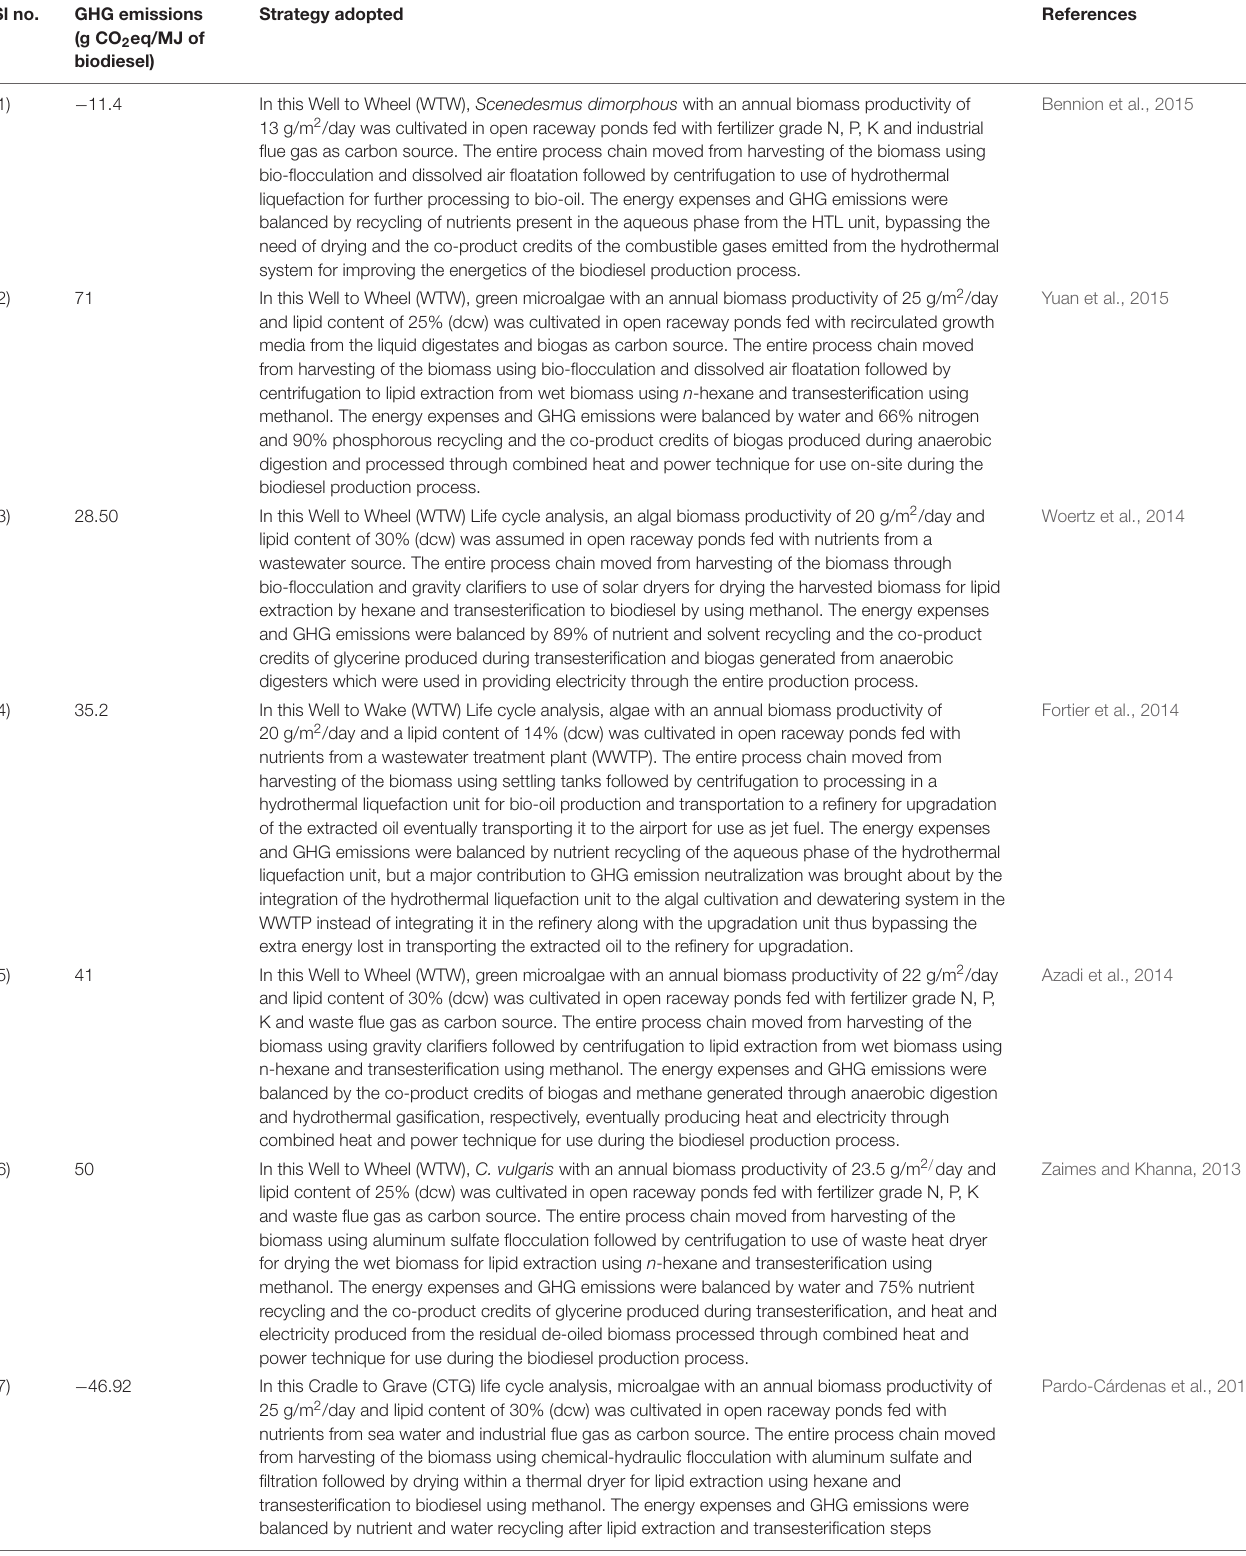
TABLE 4 | GHG emissions by microalgal biodiesel production system and strategies adopted for their reduction. Sl no. GHG emissions Strategy (g CO 2 eq/MJ of biodiesel)